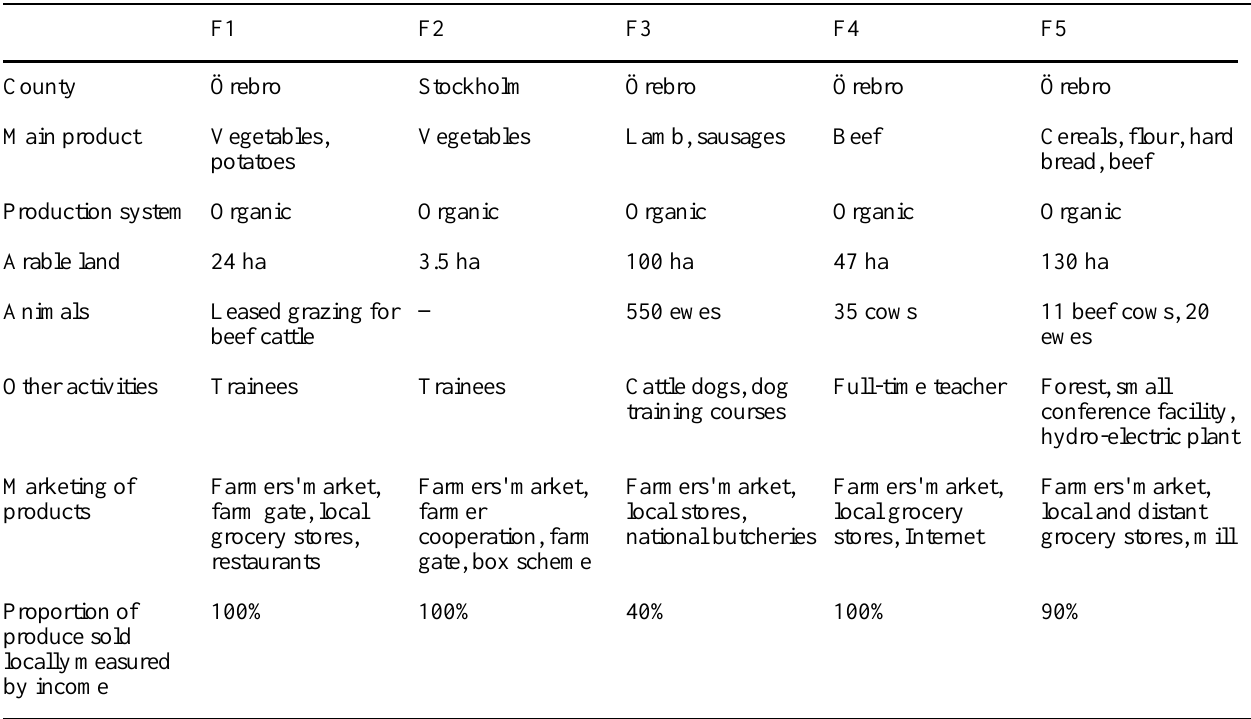
Table 1 . Descriptions of the farms in the